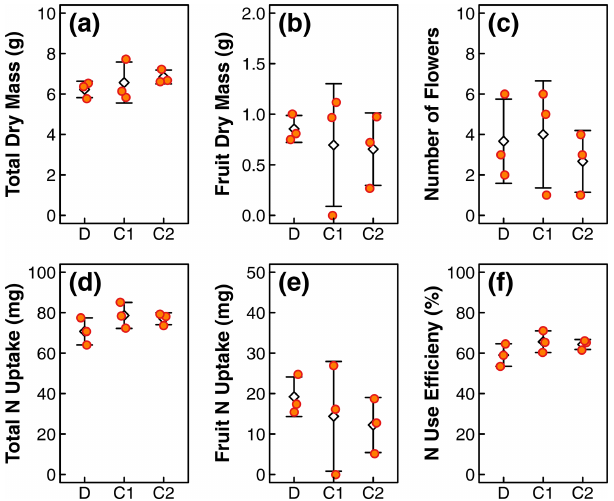
Figure 2. Comparison of plant physiological indicators, including (a) total dry biomass, (b) fruit dry mass, (c) number of flowers, (d) total N uptake, (e) N uptake in fruit, and (f) N use efficiency in treatments D, C1, and C2. The orange dots represent values of individual replicates. The white diamonds and whiskers represent the mean and standard deviation within each treatment. Distribution of N content along the canopy length is shown in Fig. 3. One of the replicates in treatment C1 did not produce fruits, resulting in larger deviations in fruit dry mass and N update in treatment C1.